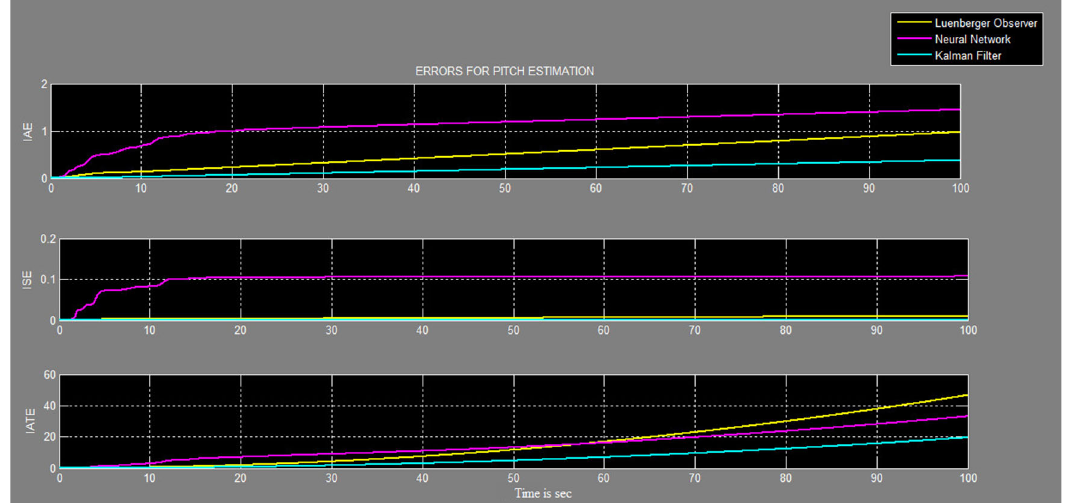
Figure 17. Comparative graph of errors in the estimation of the pitch with three different systems.